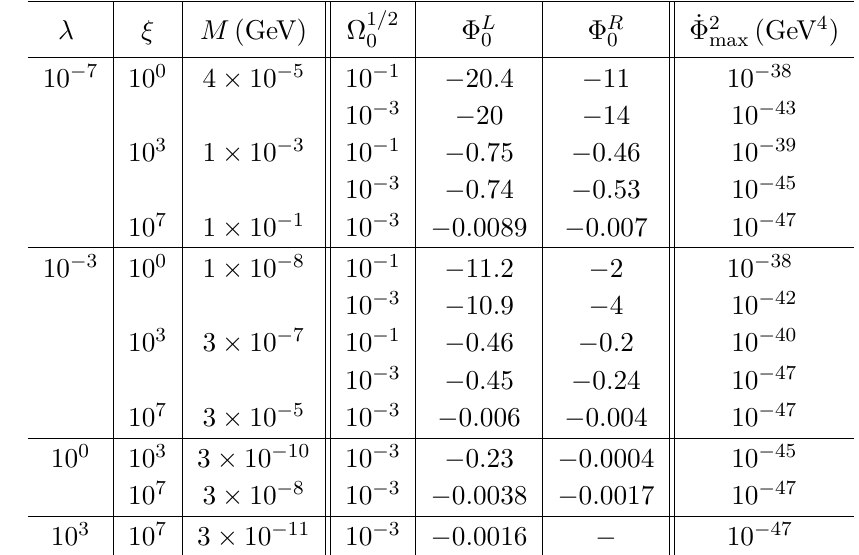
Table 3 . Value of the parameters associated to some of the evolutions of figure 3. The value of M is tuned to obtain the current value of the Hubble rate at matter-scalar equality. The initial scalar energy density Ω 0 is varied between 10 − 2 and 10 − 6 . The values Φ L,R of the field tuned to obtain between 8 and 10 e-folds of matter domination. The value ˙Φ 2 maximum value that ˙Φ 2 attains during the evolution and will be used to discuss the importance of the α ( ∇ Φ) 4